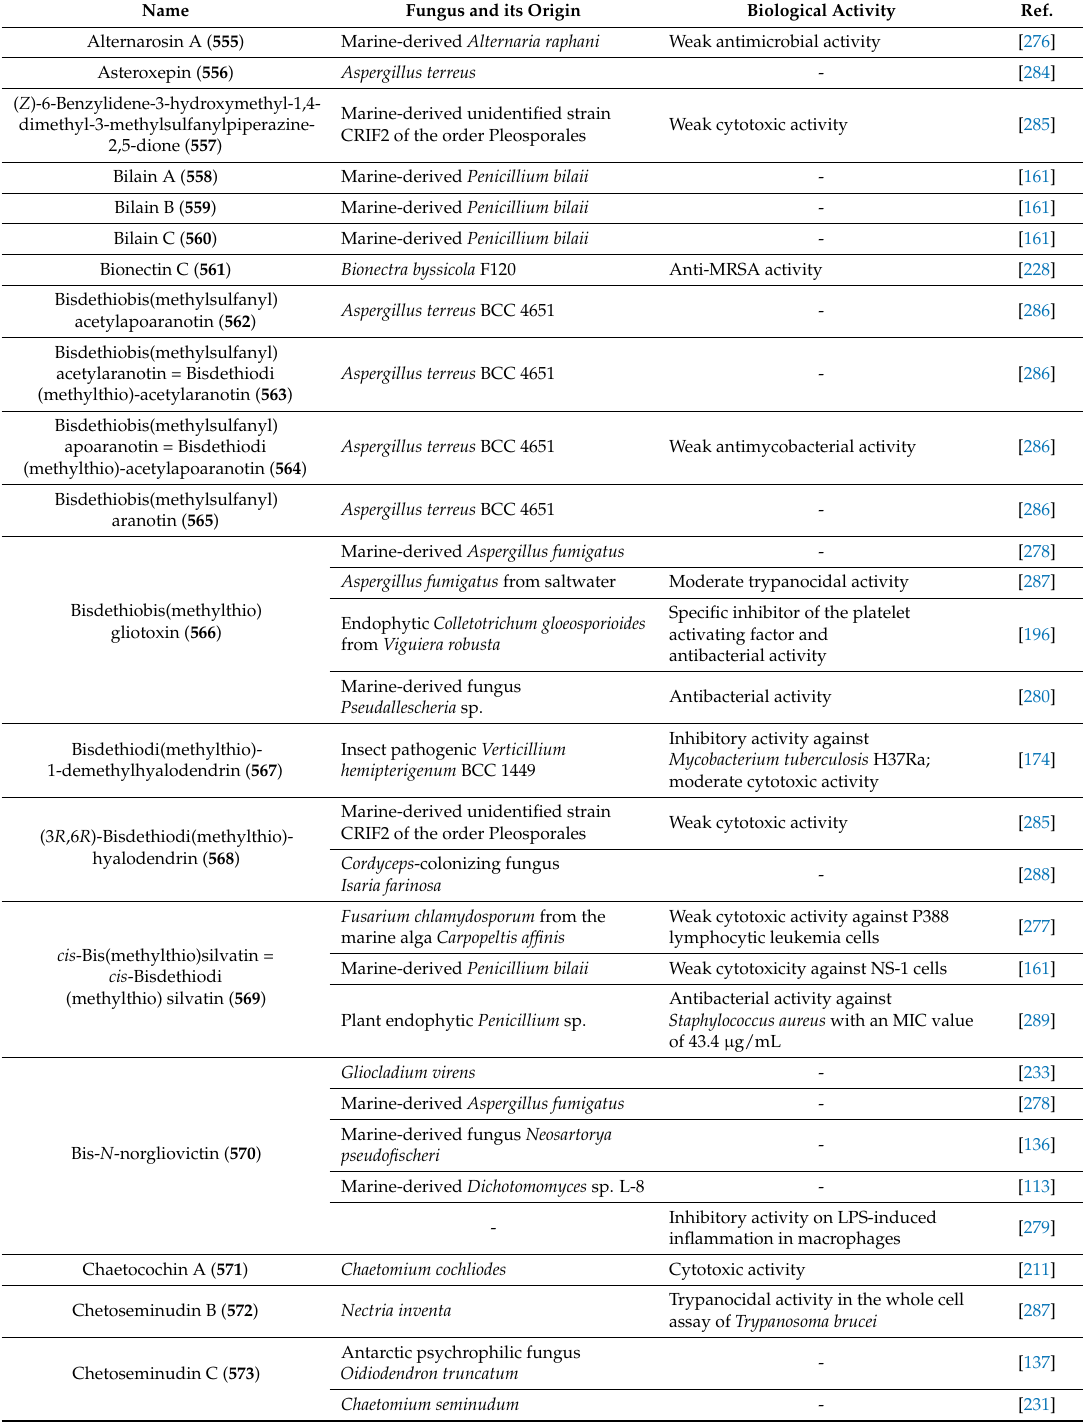
Table 8. Nonbridged methylthio-containing cyclodipeptide analogs from fungi and their biological